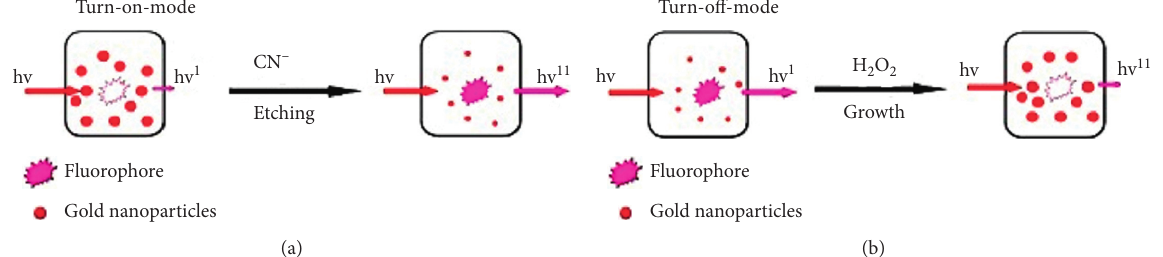
Figure 9: Scheme of IFE-based fluorescence detection process for hydrogen cyanide and hydrogen peroxide [43]. Elements of a Biosensor